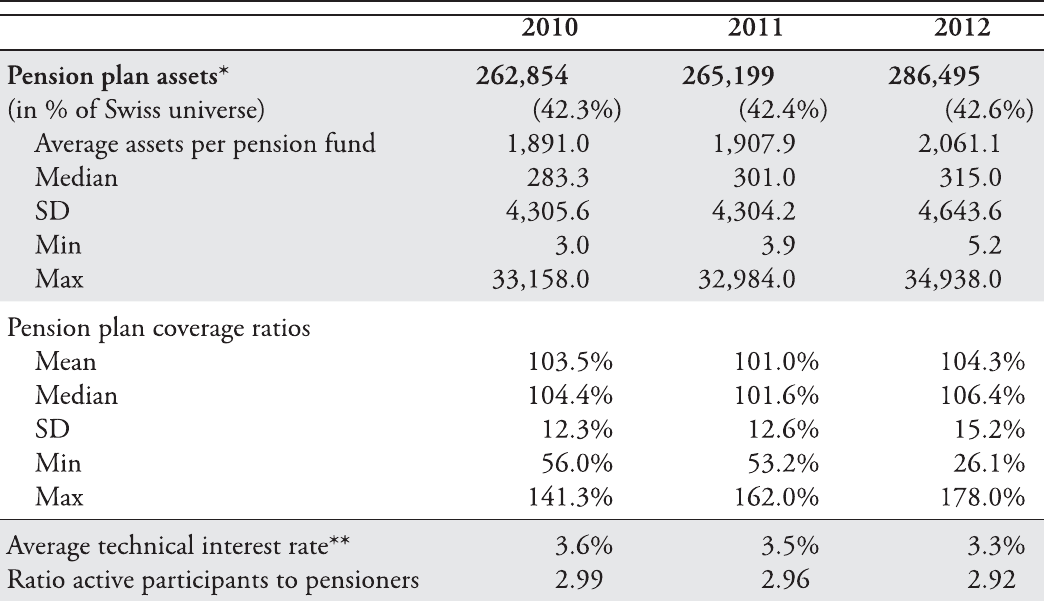
Table 8: Pension Fund Assets and Actuarial